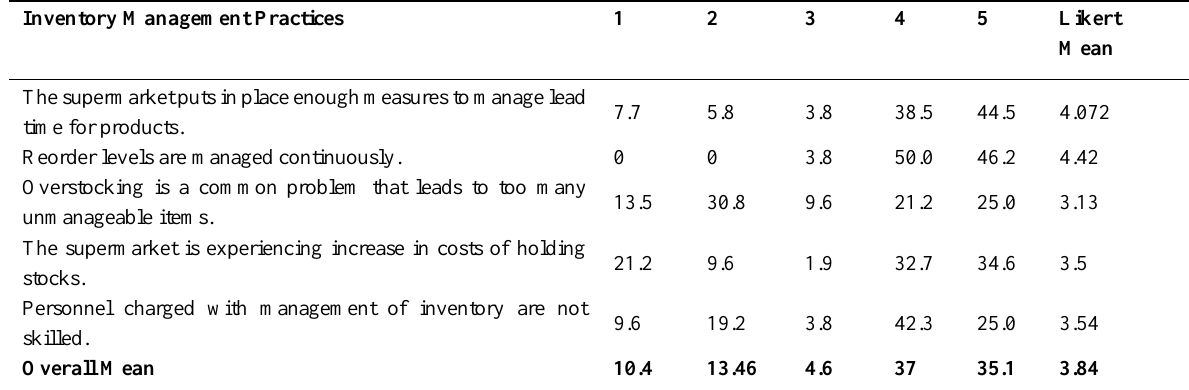
Table 1: Analysis of Inventory Management